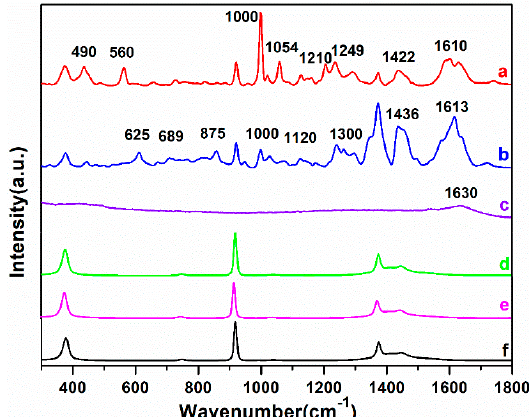
Figure 2. ( a ) The surface enhanced Raman scattering (SERS) spectra of deltamethrin (DM); (b ) the SERS spectra of carbofuran (CBF); ( c ) the Raman spectra (RS) of AuNPs; ( d ) the RS spectra of DM without AuNPs; ( e ) the RS spectra of CBF without AuNPs; ( f ) the RS spectra of